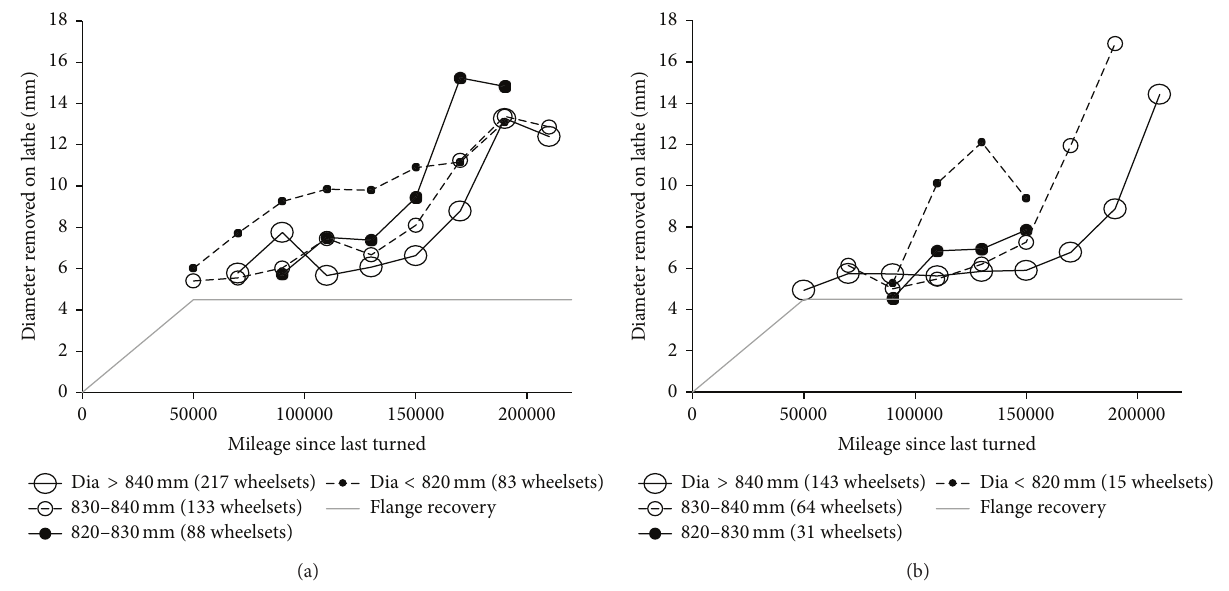
Figure 1: Influence of wheel diameter on average depth of material removal at reprofiling, as a function of mileage since last turned. This example is for the leading wheelset 1, which is most commonly affected by RCF. Wheels turned because of other damage types (e.g., flats) or for parity are excluded. (a) Wheels from all manufacturers. (b) Wheels from only one manufacturer. It is usually necessary to remove approximately 𝜑 5mm to recover the flange thickness; deeper cuts indicate that RCF damage has propagated more deeply. Both graphs show a trend that RCF becomes serious more quickly on wheels of smaller diameter.